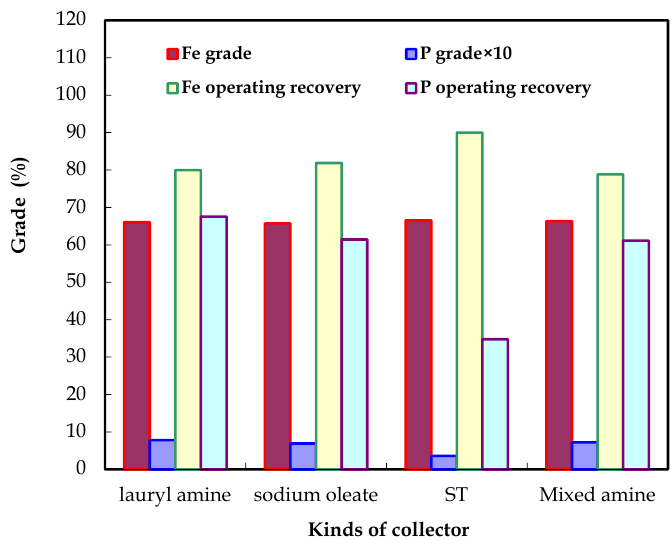
Figure 4. Effect of collector on the iron and phosphorus grades and recoveries in reverse flotation.